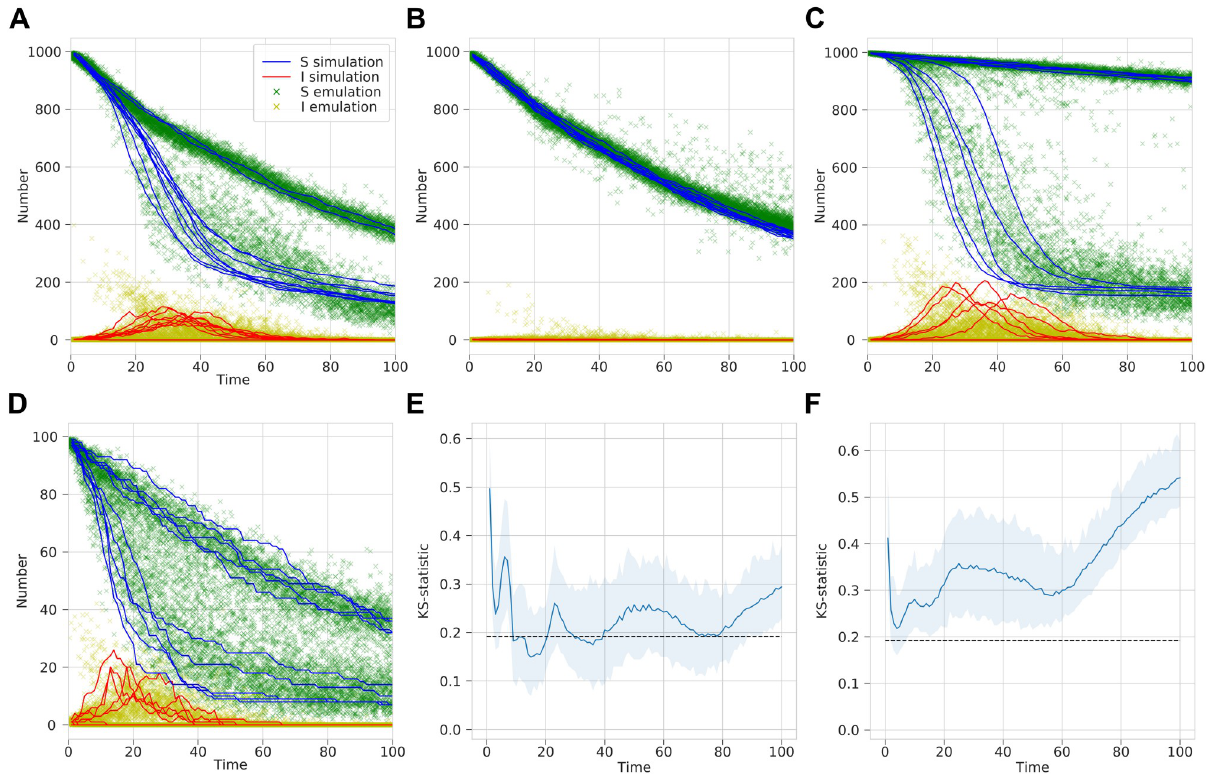
Fig 5. Beta-MDN output emulating the infection dynamics with time for a stochastic SIR model. (A–D) A comparison of simulation results with sampled MDN output for fixed γ = 0.2 and different β , δ and N values such that (A) R 0 = 2.0, δ = 0.01 and N = 1, 000, (B) R 0 = 1.0, δ = 0.01 and N = 1, 000, (C) R 0 = 2.0, δ = 0.001 and N = 1, 000, (D) R 0 = 2.0, δ = 0.01 and N = 100. (E–F) Two-sample K–S statistic where sample of 100 points are drawn from a negative binomial and the MDN over a range of time t values. 100 replicates are used to estimate a mean K–S statistic and a 95% range. Dashed line represent significance at α = 0.05, with values less indicating the two samples do not differ significantly. Tests are for (E) number of susceptible people and (F) number of infected people.